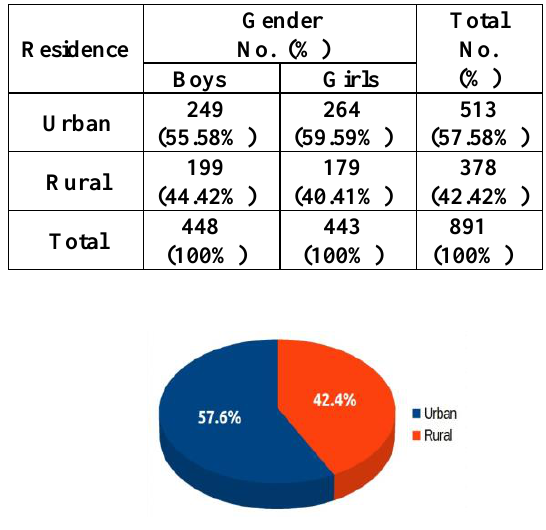
Figure 1: Residence of the sample